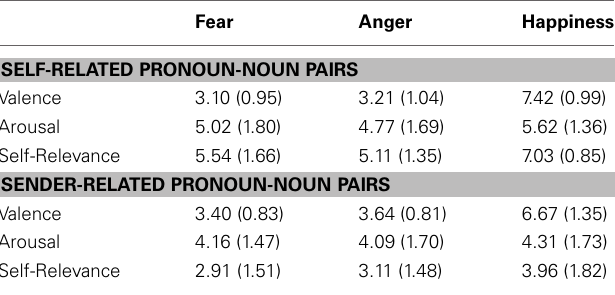
Table 2 | Experiment1: mean valence, arousal, and self-relevance ratings of self-related and sender-related pronoun-noun pairs obtained after the experimental recordings.